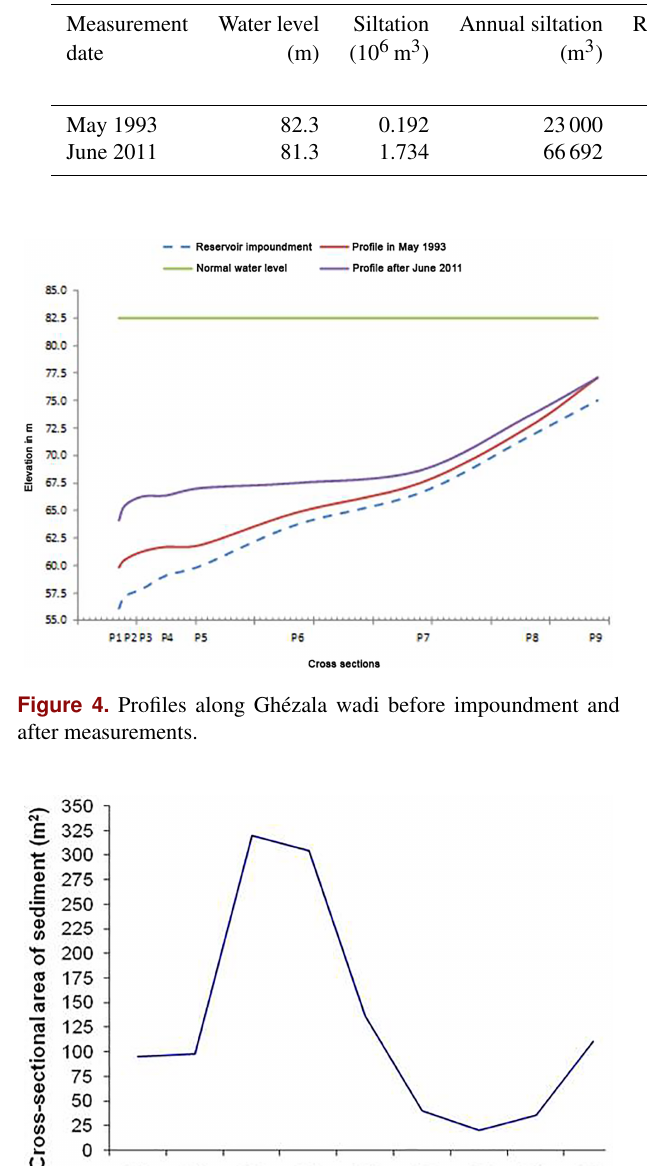
Table 1. Measurements of siltation in the Ghézala dam reservoir.